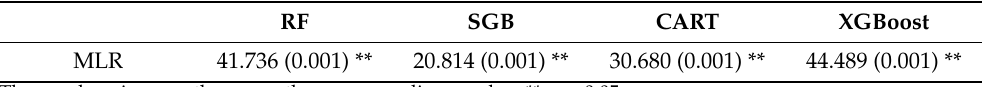
Table 5. Wilcoxon sign-rank test between four ML methods and MLR method. RF SGB CART XGBoost